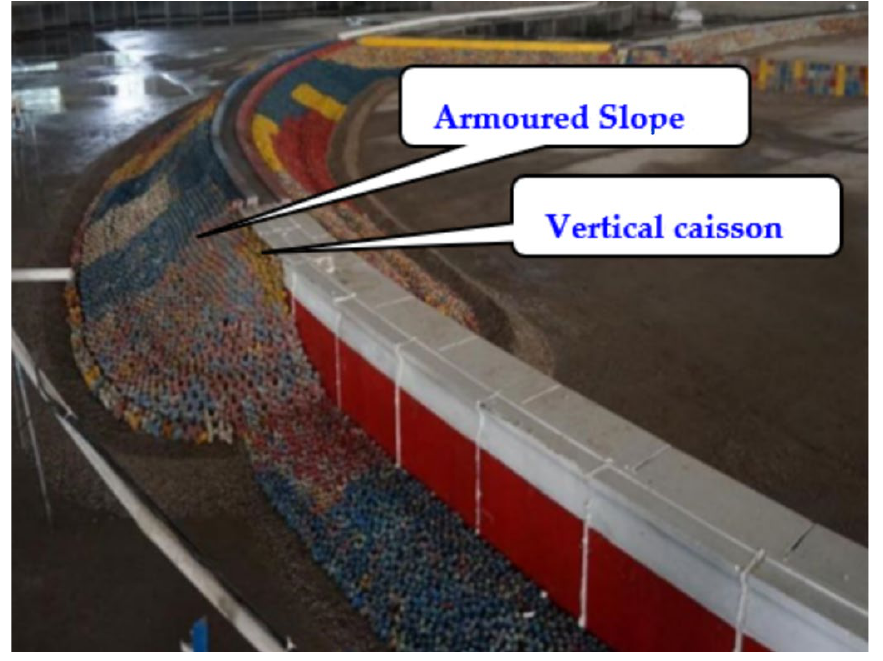
Figure 4. Layout plan of the breakwater transition on the model.